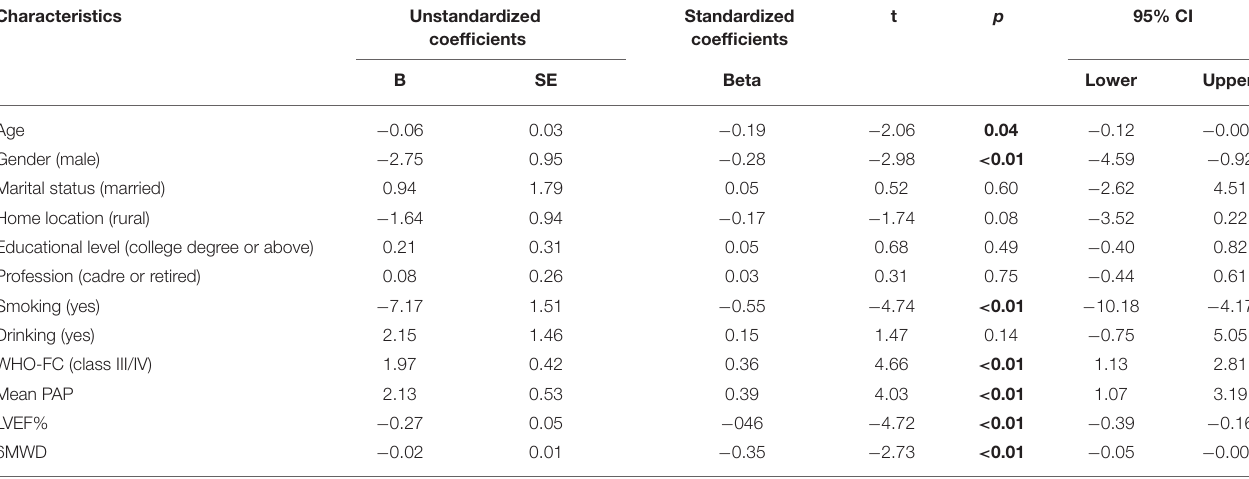
TABLE 3 | Multiple linear regression analysis of anxiety scores and general characteristics.